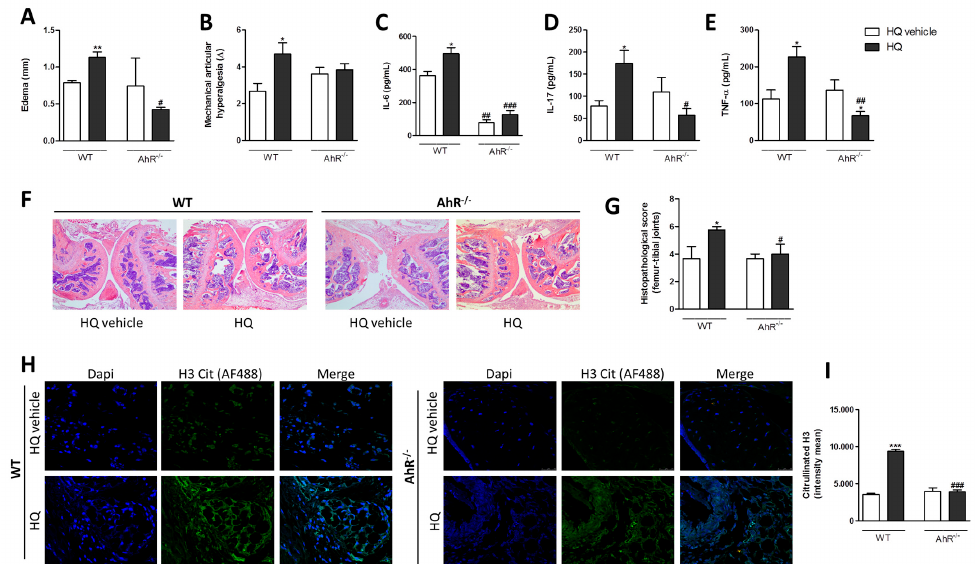
exposed to HQ or vehicle, 1 h/day between days 15–21 after the first immunization. On the 21th day after the first immunization, animals were challenged with mBSA. Six hours later, mice were euthanized and edema ( A ), mechanical articular hyperalgesia ( B ), quantification of cytokines IL-6 ( C ) and IL-17 ( D ), TNF- α ( E ), histopathological analyses ( F , G ) and indirect immunofluorescence analyses of NET formation by assessing the quantification of H3 citrullination ( H , I ). ( F ): original magnification—4 × . ( H ): original magnification—40 × . Data represent mean ± SEM of four animals in each group and were analyzed by one-way ANOVA. * p < 0.05, ** p < 0.01 and *** p < 0.01 vs. HQ vehicle; # p < 0.05, ## p < 0.01 and ### p < 0.001 vs. respective group in WT mice.